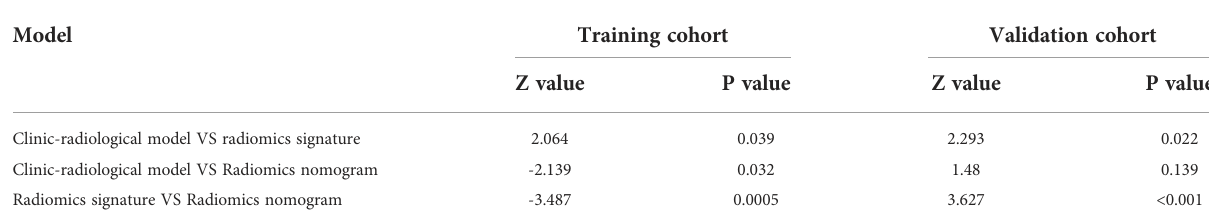
TABLE 4 AUC comparison of three prediction